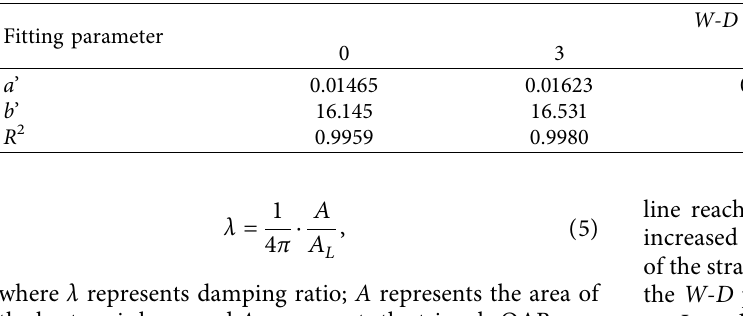
c d and d of W - D cycle path d